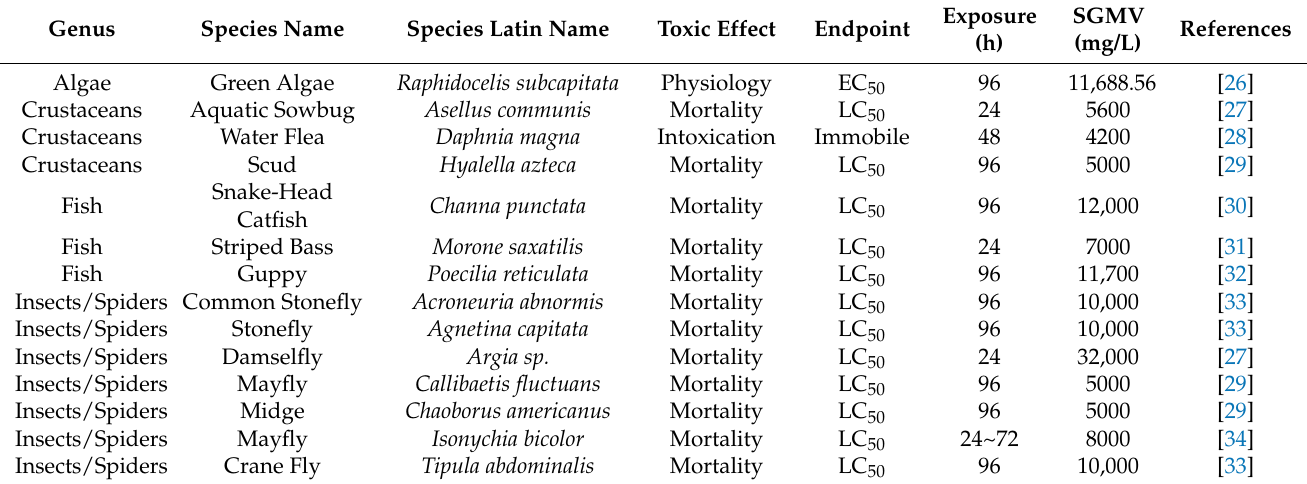
Table 4. Toxicity data of chloride to aquatic organisms.